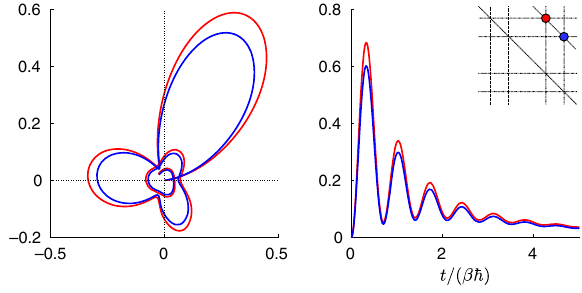
FIG. 10. Off-diagonal fluctuation relation. The fluctuation theorem (50) relates the evolution of the coherences carried by two off-diagonal elements along a displaced diagonal. The plot on the right displays j q j (red curve) and j q − j (blue curve) plotted þ as functions of time. The plot on the left depicts the trajectories (red curve) and q − (blue curve) sweep in the complex that q þ plane during the same time interval. As predicted by Eq. (50), j q j and j q − j are proportional to each other, and the phase factors þ and q − are identical. Analogous to how the classical of q þ FIG. 9. Decoupling of the modes of coherence in a dissipative Jaynes-Cummings model. A harmonic oscillator, with energy eigenbasis j n i , serves as the energy reservoir in interaction with an open two-level system. As the initial state of the energy reservoir, we choose the (rather arbitrary) superposition of number states j ψ i¼ðj 9 iþj 15 iþj 42 iþj 47 iþj 50 iþj 67 iþj 79 iÞ = ffiffiffi p 7 . The red dots represent the nonzero matrix elements of the density operator j ψ ih ψ j with respect to the number basis. The ~ F conditional evolution on the energy reservoir, defined in þ Eq. (42), is calculated for the evolution time t= ð β ℏ Þ ¼ 1 . 5 , and ~ F the dark colors correspond to the values jh n j ðj ψ ih ψ jÞj n 0 ij . The þ upper left corner, n ¼ n 0 ¼ 0 , corresponds to the probability of finding the oscillator in the ground state, and the main diagonal n ¼ n 0 is the probability for the excited states. The off-diagonal elements, n ≠ n 0 , represent the coherences between the energy eigenstates. One can recognize the leakage of energy out of the oscillator, as well as the decay of coherence. It is also clearly visible how each initial off-diagonal element only evolves and spreads along the particular diagonal that it belongs to, thus illustrating the decoupling of the modes of coherence.